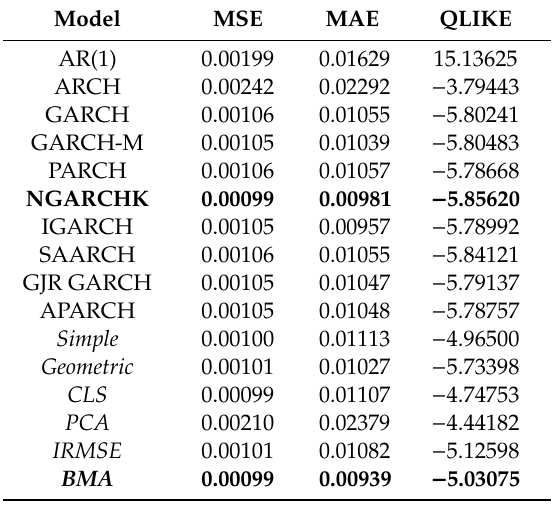
Table 6. SREC prices forecast loss functions. Best performing models / combinations in bold. Combinations in